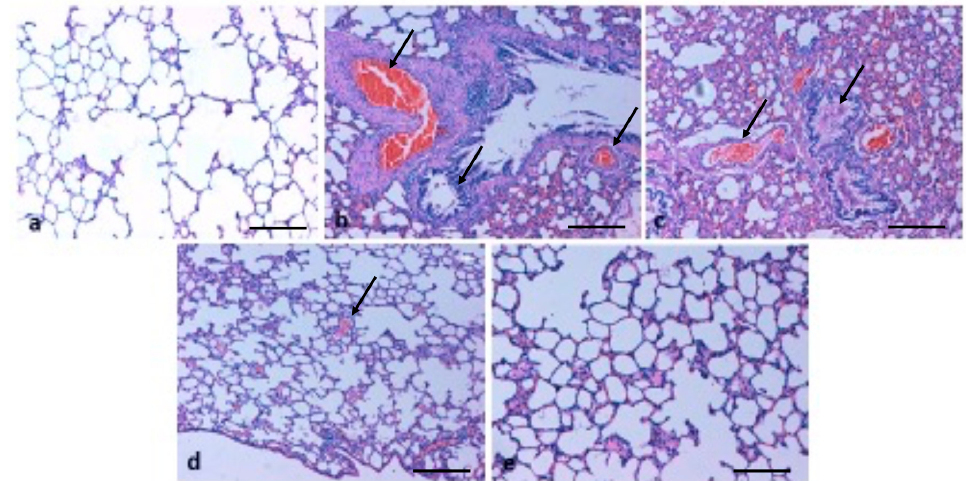
Figure 6. Histopathological changes of lung tissues in different animal groups. ( a ) Typical lung architecture in control rats includes normal airway bronchi and bronchioles and blood vessels and alveolar sacs. ( b , c ) B(a)P mediated the lung epithelium thickening, damage of the alveolar architecture, and infiltration of inflammatory cells within lung tissues, incidence of congestion and haemorrhage. The arrows indicate infiltration of inflammatory cells and congestion. ( d ) Histopathological changes were found to be considerably lower with TQ plus B(a)P co-administration, as this attenuated the damage to lung epithelium and alveolar architecture and decreased the incidence of edema. The arrow indicates less edema. ( e ) Thymoquinone-only treated group shows normal lung architecture (Scale bar = 100 µ m).